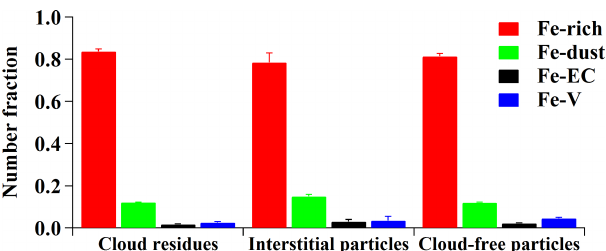
Figure 2. Number fraction of the four Fe-containing types in the Fe-containing cloud residues, interstitial particles, and cloud-free particles during the whole study period.